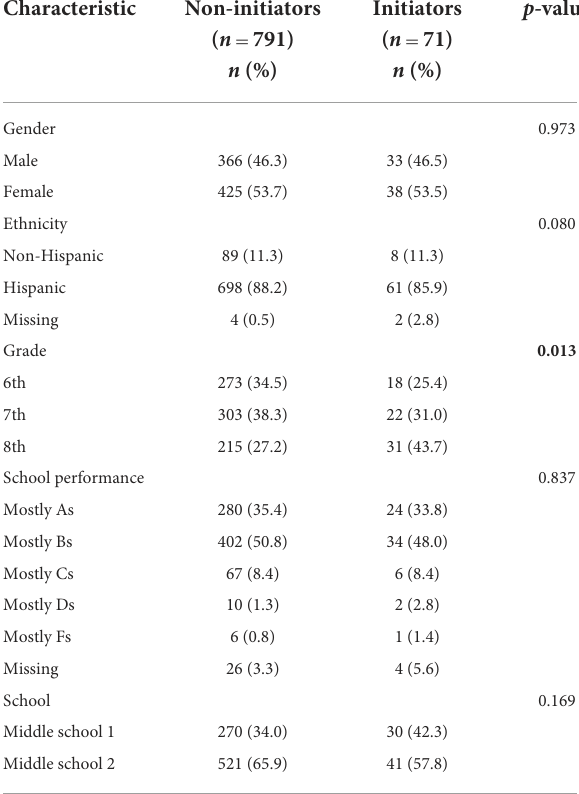
TABLE 1 Key characteristics by e-cigarette status at follow-up ( n = 862).